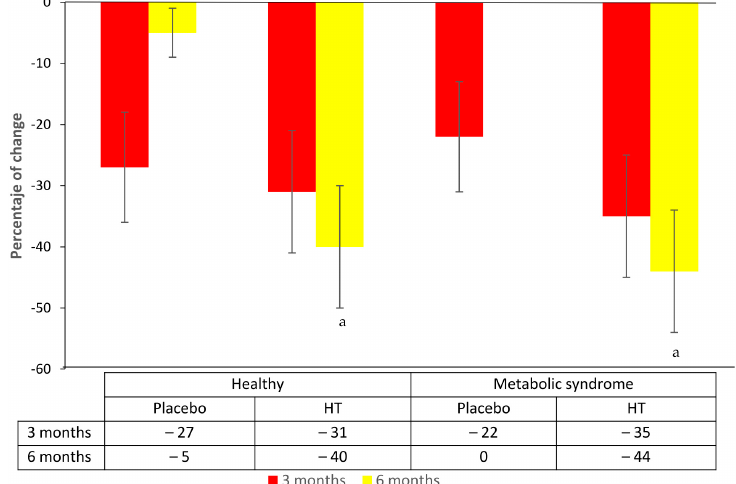
Figure 3. Percentage change of oxidative stress (stress score ≥ 4) after 3 and 6 months of treatment. Error bars are proportion standard error. McNemar chi square test. a basal vs. 6 mo., p < 0.05; HT: hormone therapy.